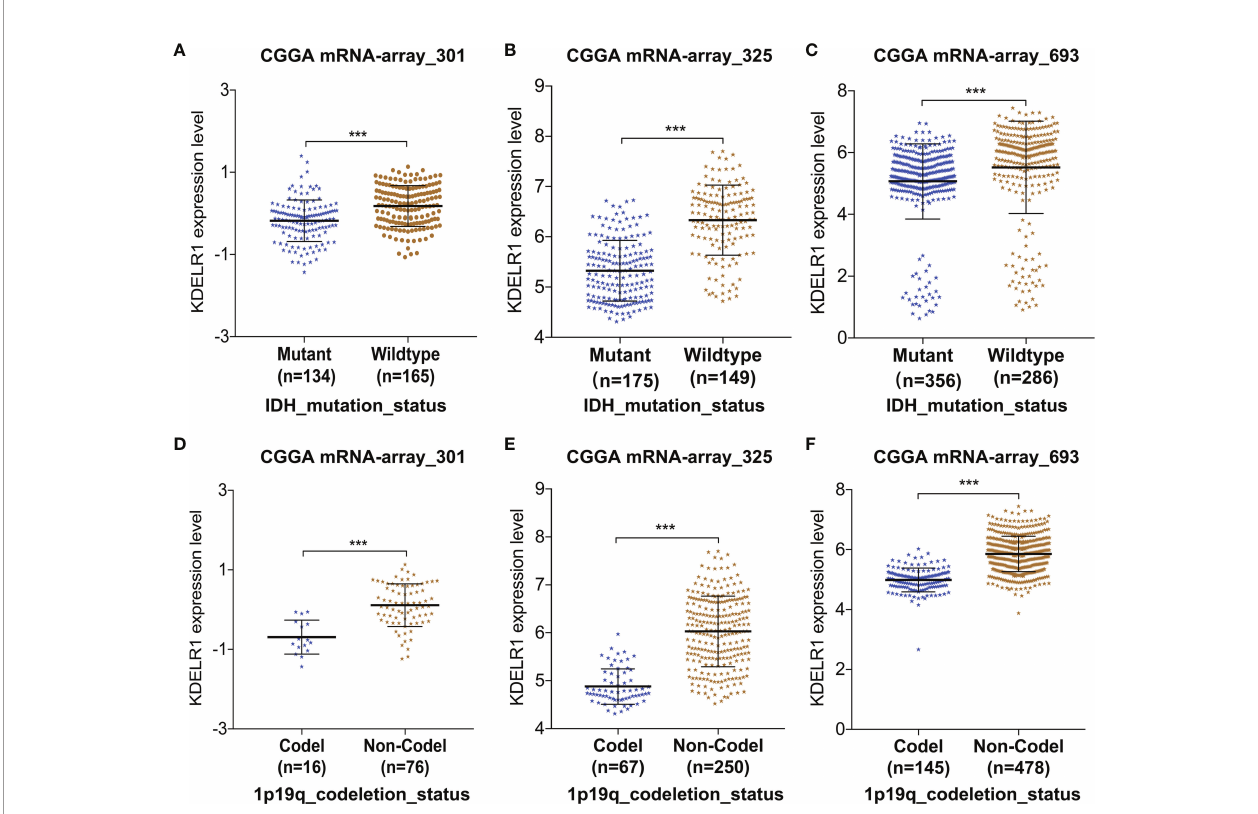
FIGURE 5 | The relationships between KDELR1 expression and IDH mutation and the 1p/19q codeletion status in the database CGGA. (A – C) Gliomas with IDH mutation had a lower KDELR1 expression than gliomas with IDH wildtype. (D – F) Overexpression of KDELR1 was frequent to occur in the glioma samples without 1p/19q codeletion. ***P <